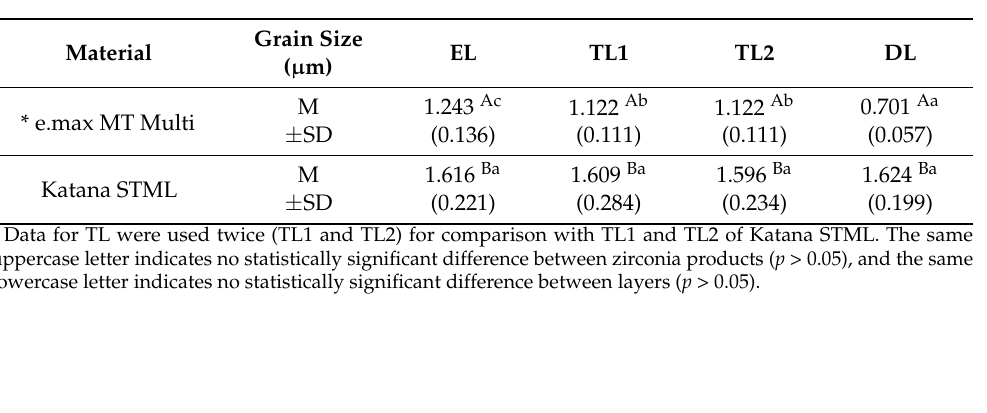
Figure 4. Microstructure for each layer of sintered zirconia. Table 4. Average grain size obtained for each